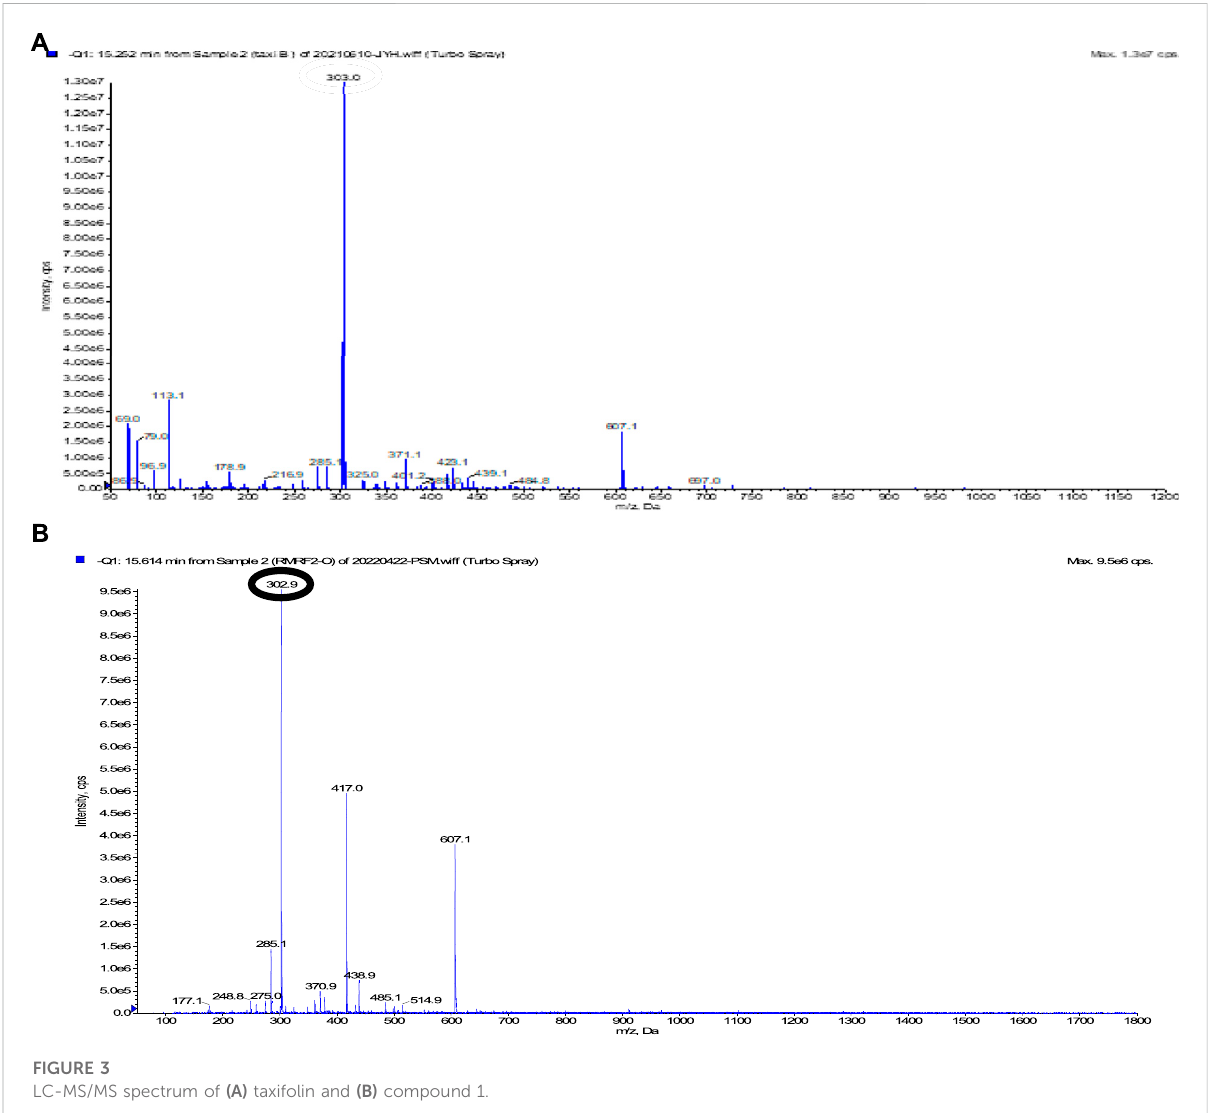
LC-MS/MS spectrum of (A) taxifolin and (B) compound